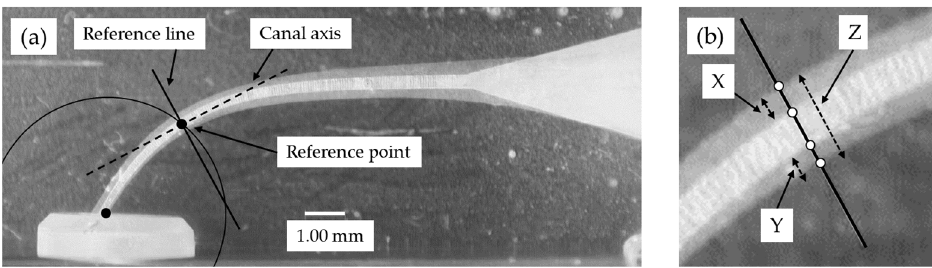
Figure 2. The method for measuring the amount of material removal. Photoshop software was used to superimpose images obtained before and after instrumentation. ( a ) A reference line is drawn by the determination of a reference point where the pre-instrumentation canal axis crosses a circle (0, 0.5, 1, 2, or 3 mm in diameter, corresponding to each measuring level) centering the pre-instrumentation canal apex; followed by the determination of a reference line as the line orthogonal to the canal axis passing through the reference point. ( b ) Four points are set at the intersections of the reference line and the pre- and post-instrumentation canal contours to measure the values corresponding to X, Y, and Z (see text above).